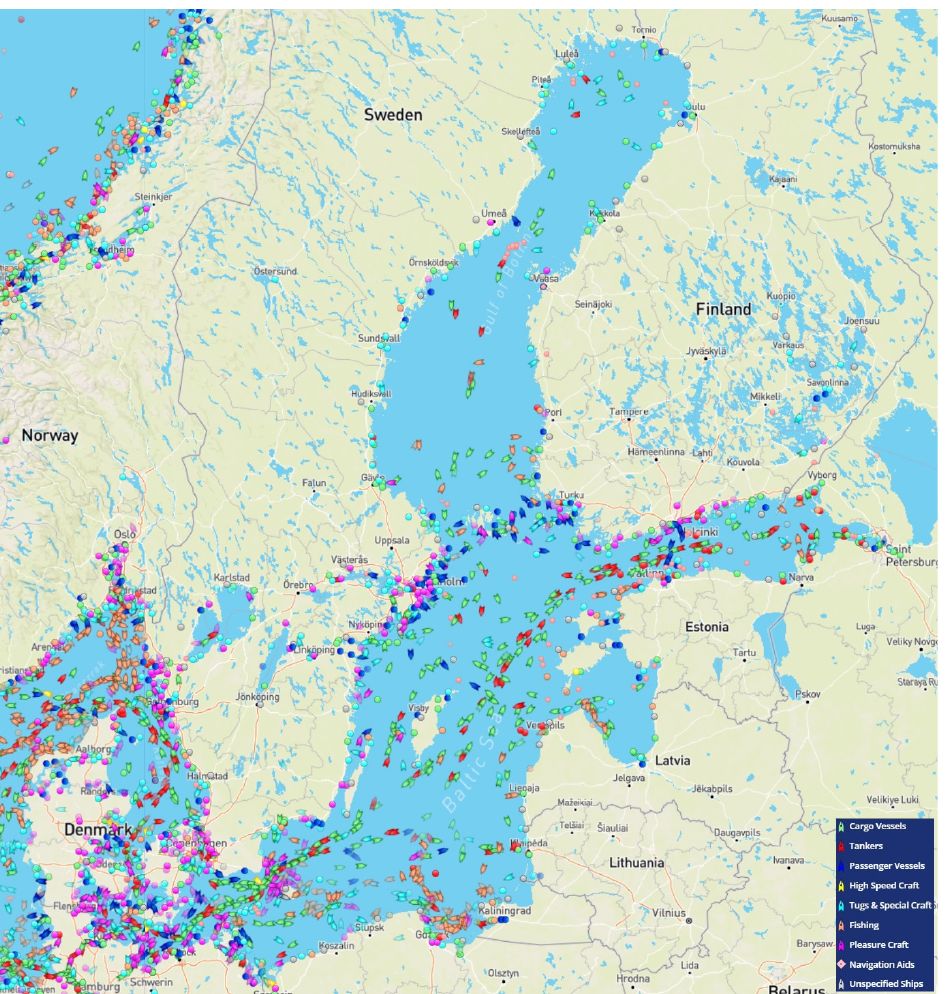
Figure 6. Number of moving ships on the Baltic Sea waters, generated from: Marine Traffic [6] (27 April 2022, 13:16).